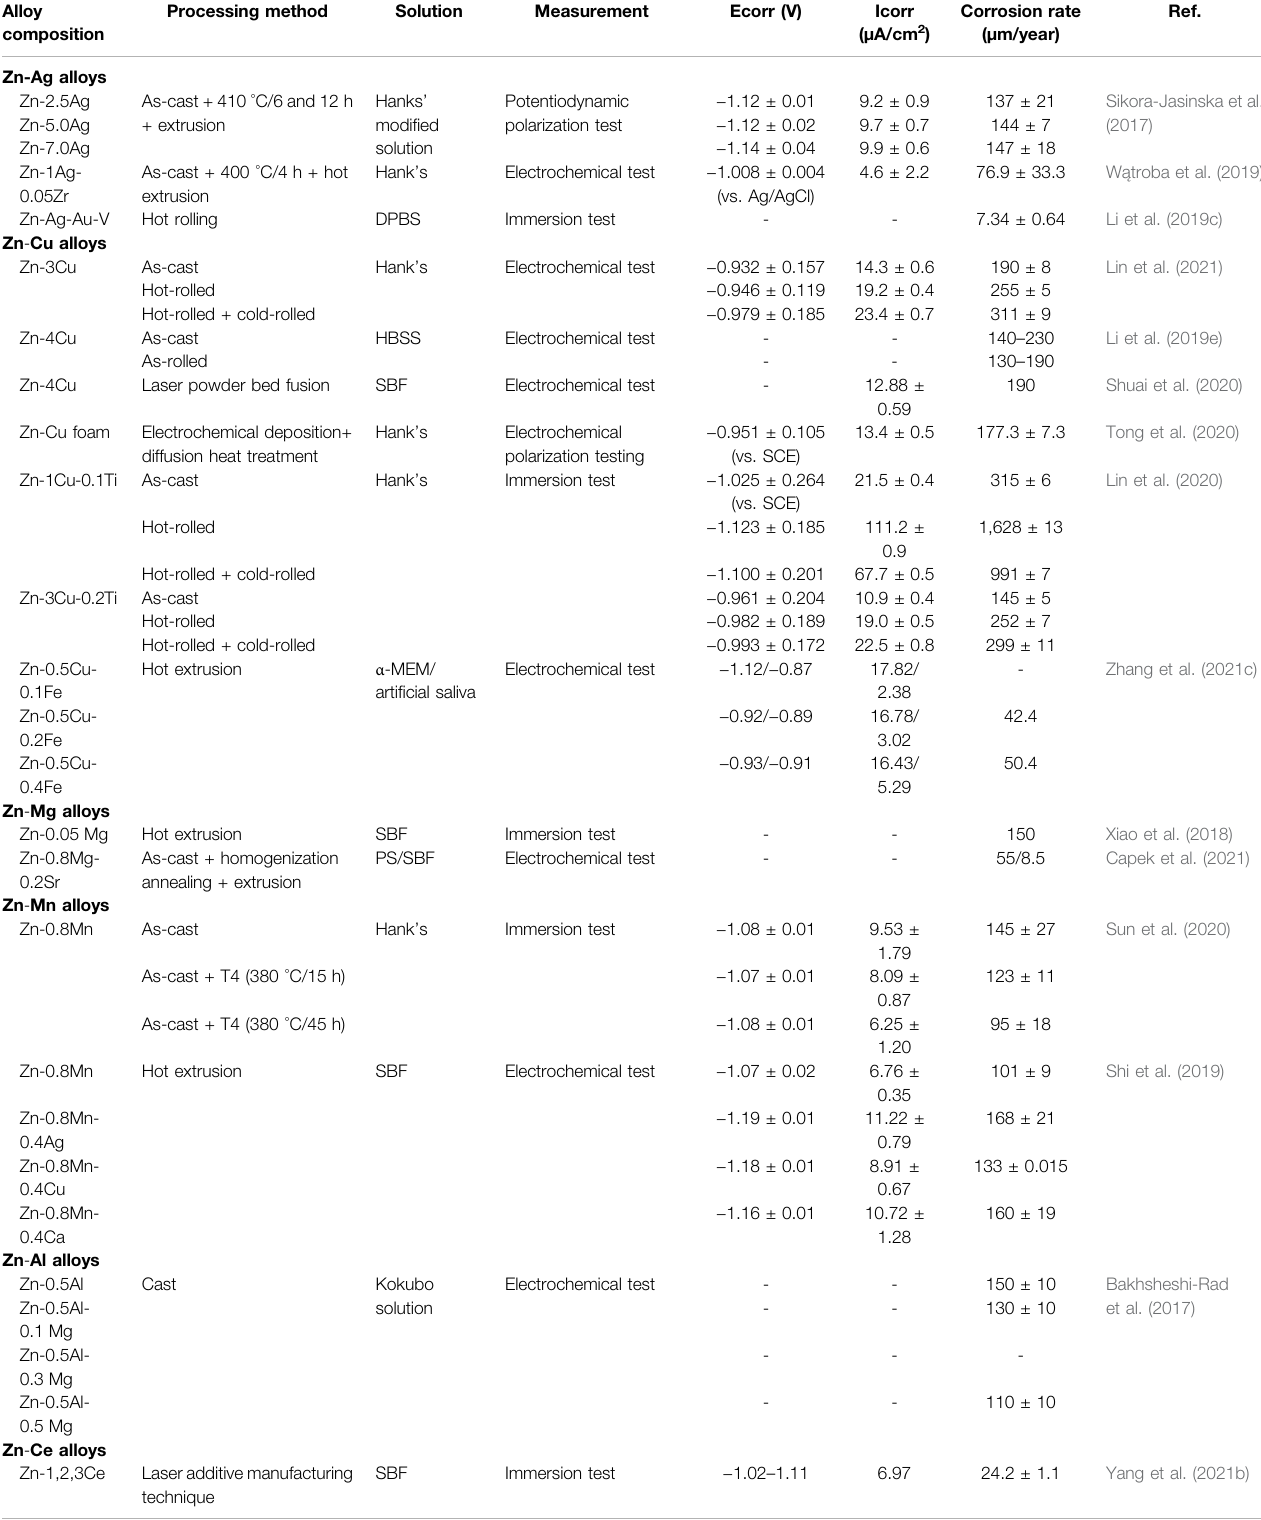
TABLE 11 | Corrosion resistance of Zn-based alloys with antibacterial properties as orthopedic implants. Alloy